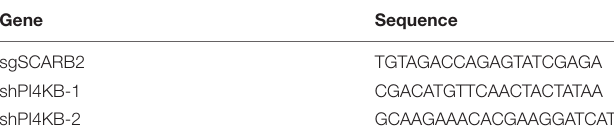
TABLE 3 | sgRNA and shRNA target